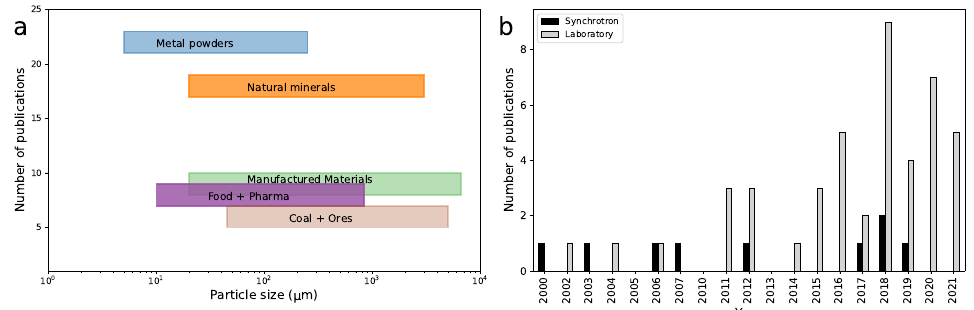
Figure 1. Diagrams summarising the history of use of X-ray CT for particle size characterisation. ( a ) The number of publications for different material categories. The category “natural minerals” contains studies that used naturally occurring minerals, such as naturally occurring sand [6,11,14,27,49,56,59] or crushed granite [42], while the category “manufactured materials” contains artificially-created particles, such as beads made from glass [1], acrylic [5], gypsum [17], or ceramic [39]. The particle size ranges measured within each category are shown on the x-axis. ( b ) The number of publications utilising particle size characterisation with X-ray CT since the year 2000, split into use of synchrotron vs. laboratory X-ray sources.